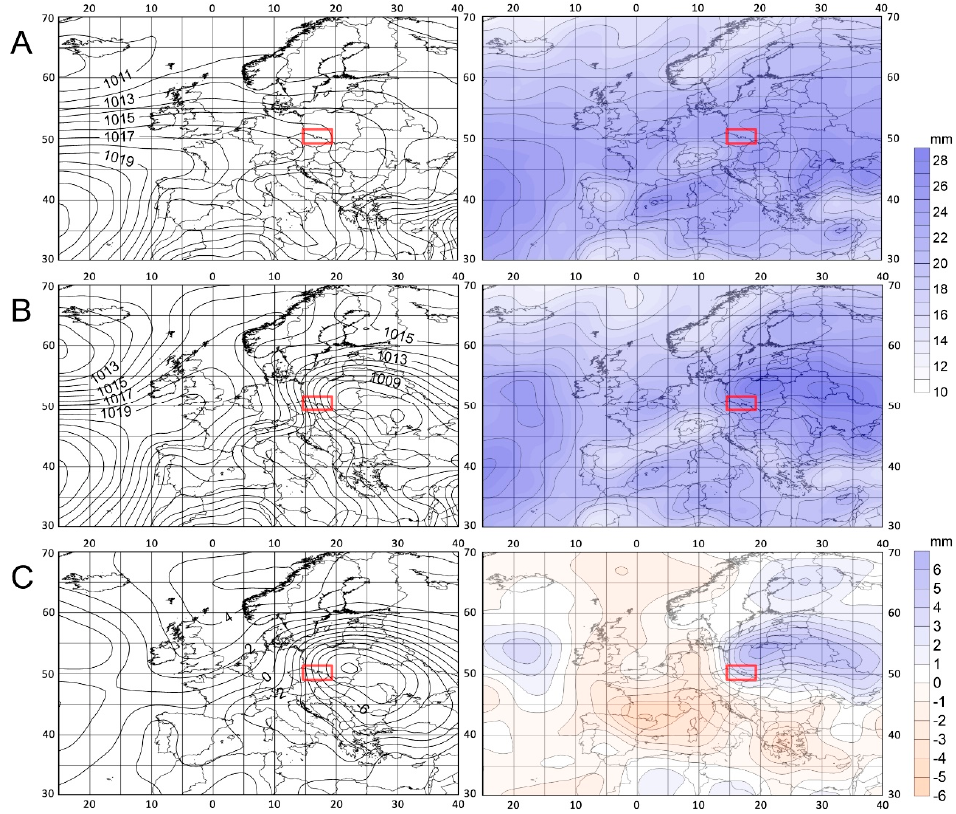
Figure 4. Mean see level pressure (SLP) (hPa) (( A ), left) and precipitable water (PW) (mm) (( A ), right) in the summer season, and mean SLP (( B , left) and PW (( B ), right) on the flood culmination day and their anomalies ( C ); ( B , C )—composites of all 17 cases of flood. Region of Polish Sudeten Mountains marked as red